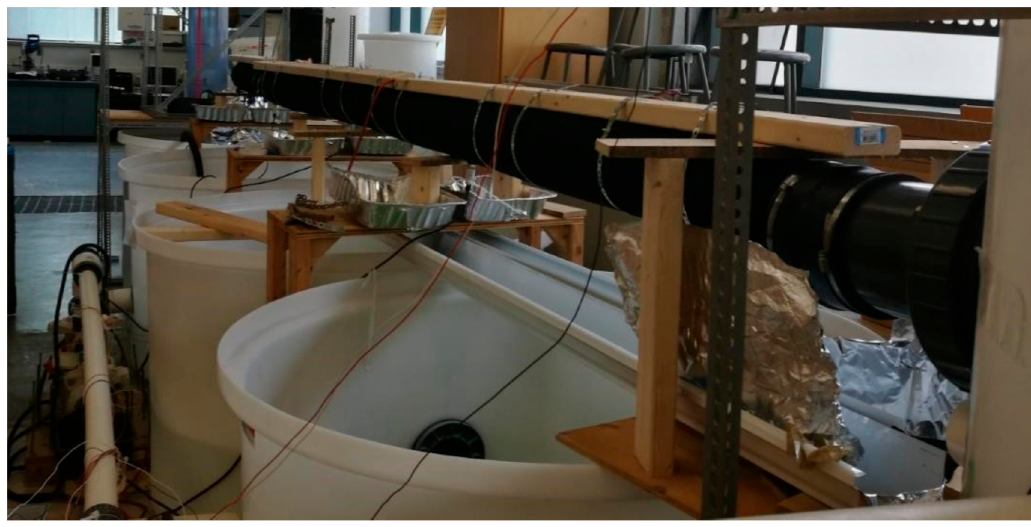
Figure 7. Photograph of the experimental apparatus.